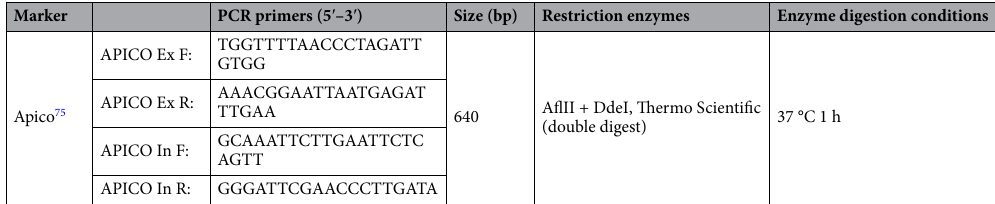
Table 3. Overview of primers, enzymes and conditions used for multiplex multilocus nested PCR-RFLP typing of the Toxoplasma gondii isolates in the present study.